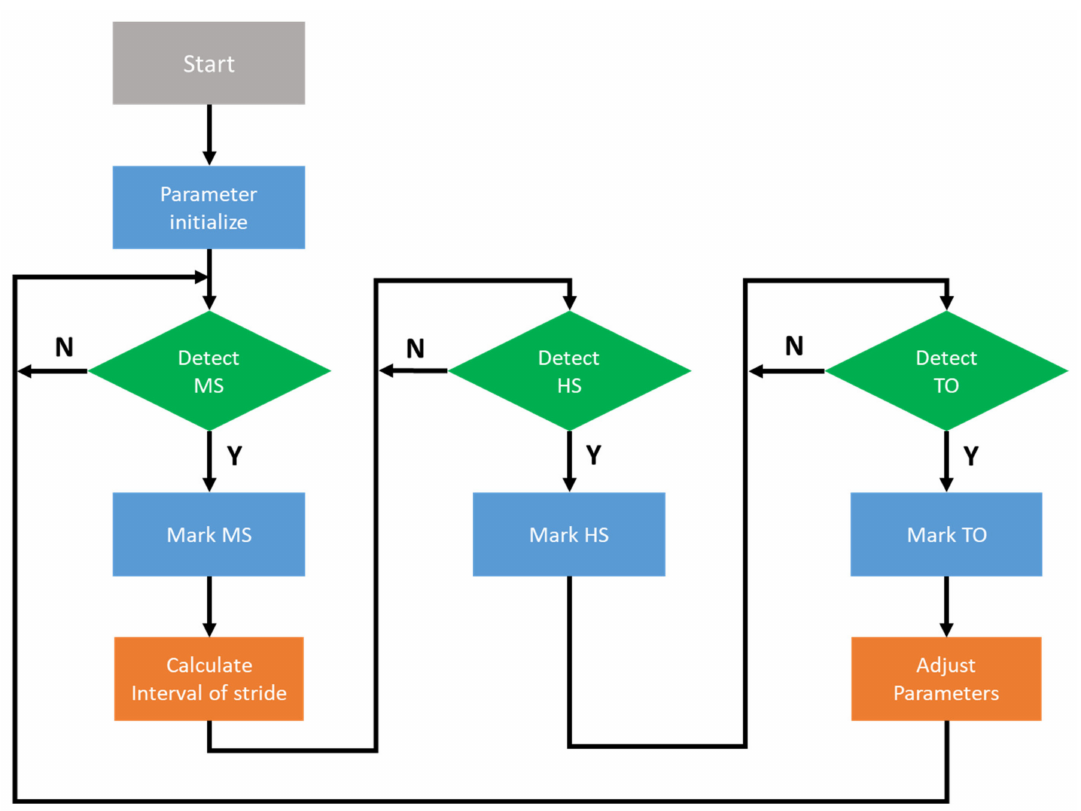
Figure 7. Flow chart of the gait detection